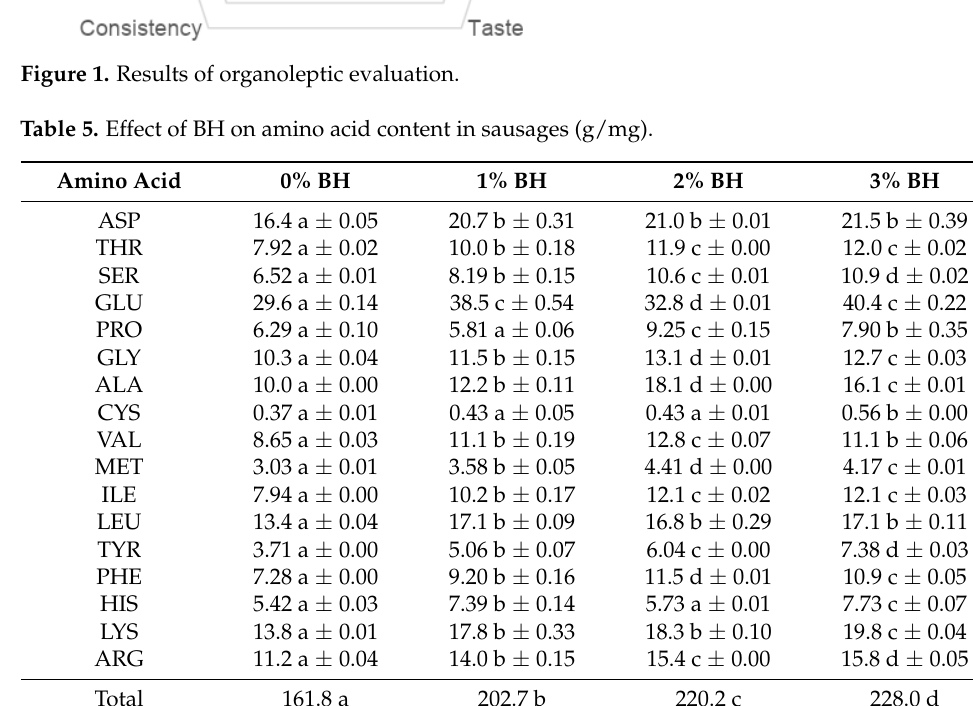
Table 5. Effect of BH on amino acid content in sausages (g/mg).